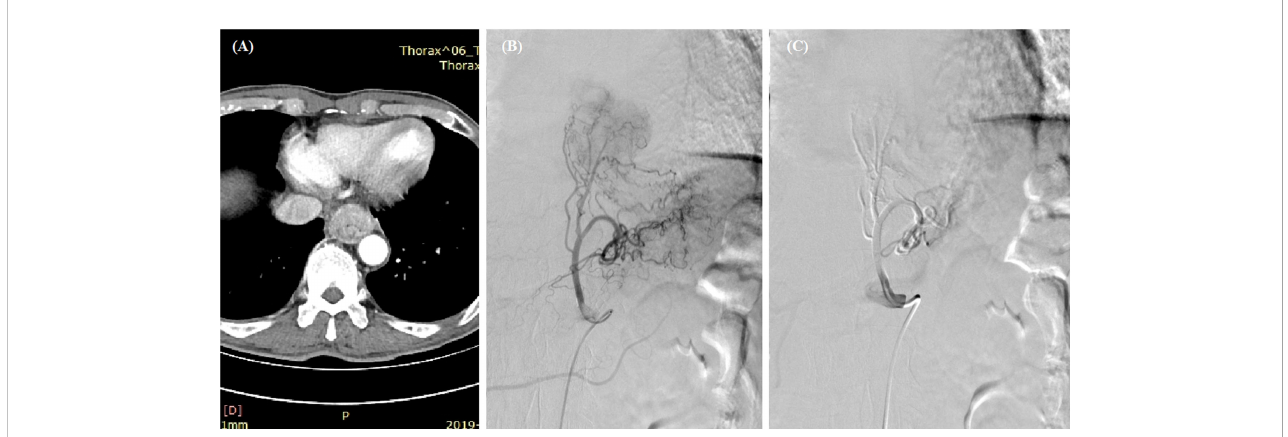
FIGURE 1 Transarterial chemoembolization for esophageal cancer. (A) A thickened esophageal wall was observed in the lower esophagus. (B) Staining of the tumor and its feeding artery were observed after angiography. (C) The left gastric artery was embolized with 350- to 560- m m polyvinyl alcohol particles after the infusion of 100 mg of oxaliplatin and 250 mg of fl